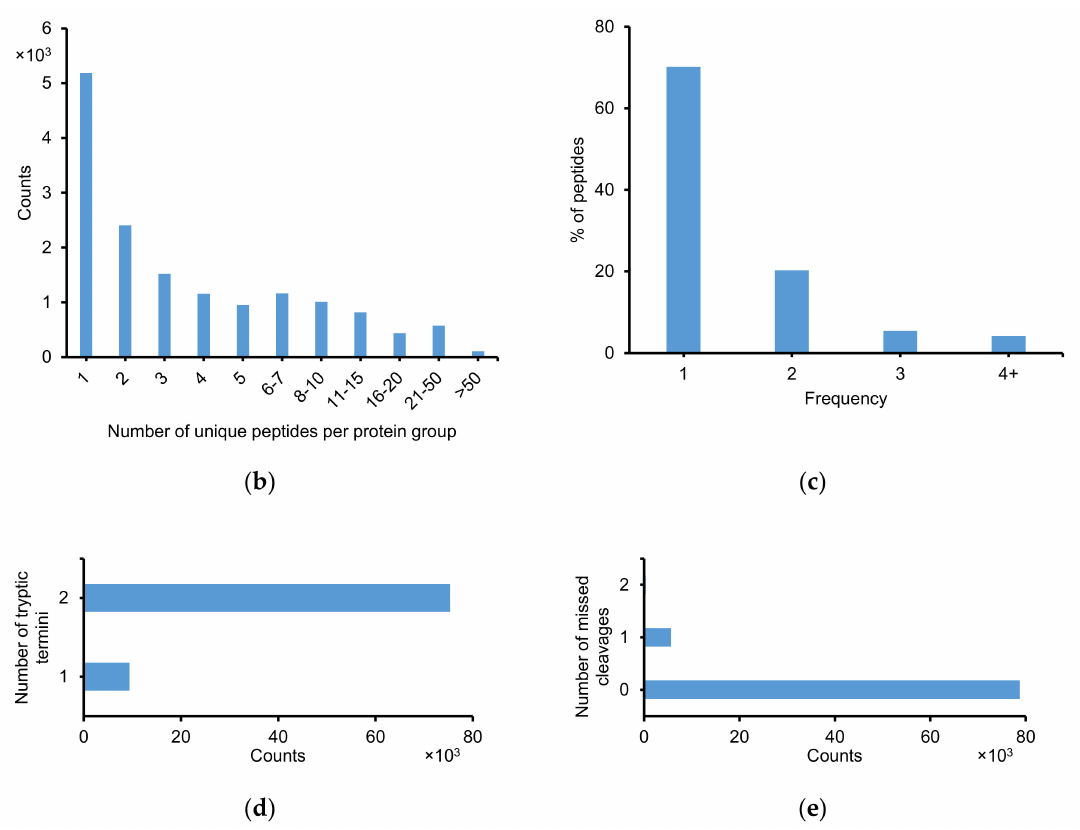
Figure 2. Summary of the results from proteomic profiling of E. huxleyi using 3D-LC system. ( a ) The accumulated numbers of identified peptides and protein groups (single hit included) versus the number of fractions. ( b ) Number of unique peptides per protein group. ( c ) Distribution of peptides by frequencies in 70 fractions. ( d ) Number of tryptic termini in identified peptides. ( e ) Number of missed cleavages in identified